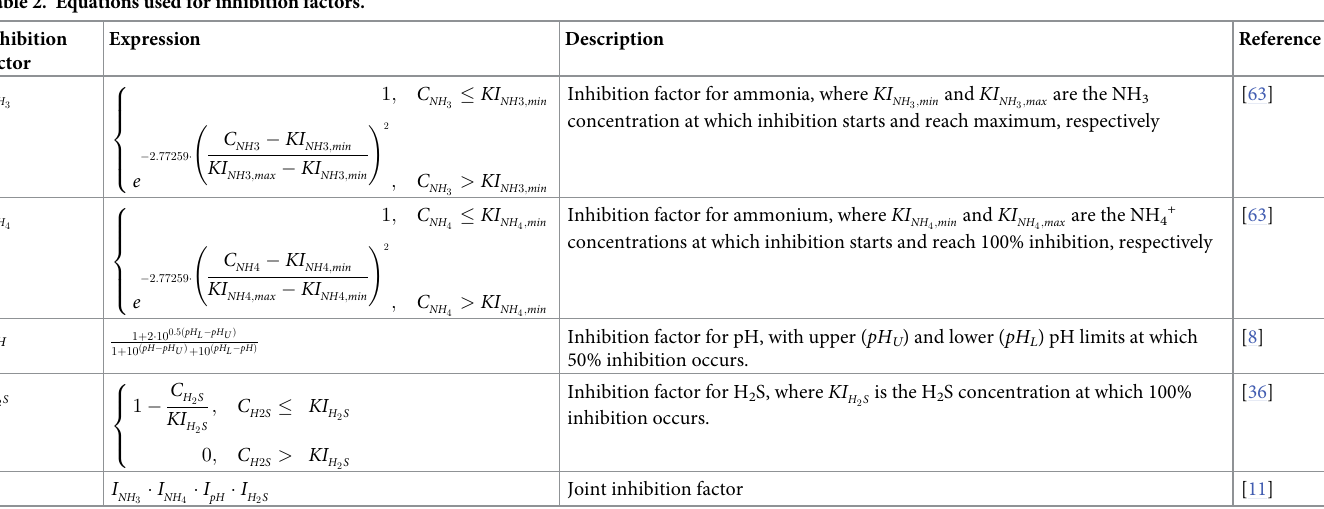
The substrate utilization rate for sulfate reducers, r 4) [36].